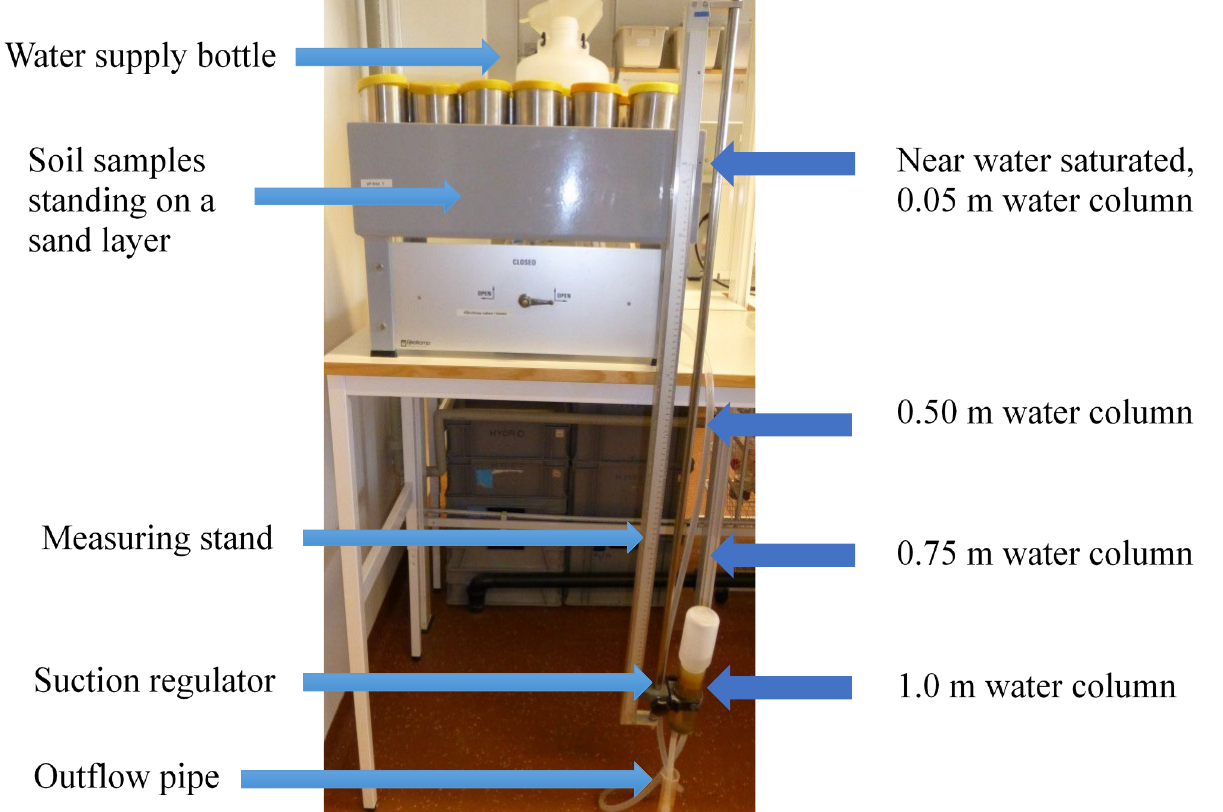
Figure 1. The sand bed that was used to apply suction to the soil samples. The difference in height between the suction regulator and mid-depth in the soil samples determines the amount of suction. Suction heads between 0 m and 1.0 m can be applied. Examples of suction heads used in this study are shown on the right- hand side of the picture.